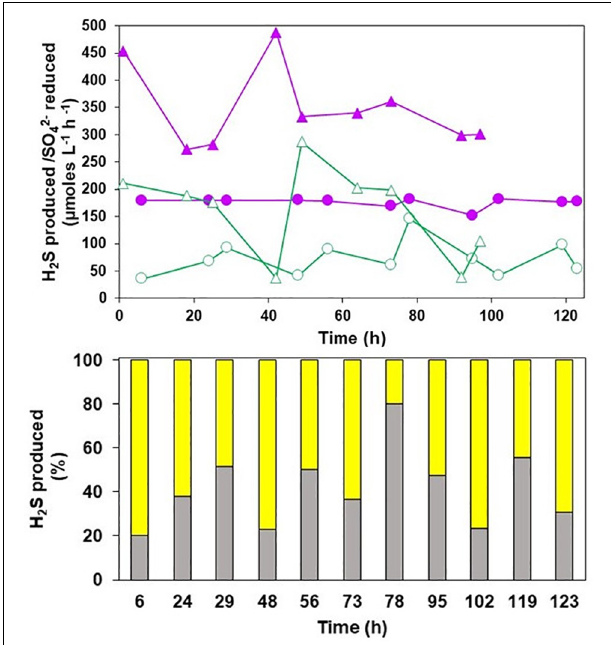
FIGURE 4 | (Top) Rates of hydrogen sulfide production (closed symbols) and sulfate reduction (open symbols) during in-line treatment of synthetic mine water ( (cid:78) , (cid:77) ) and actual MIW ( • , ◦ ) from Minsterley Brook. (Bottom) Relative amounts of hydrogen sulfide produced via the dissimilatory reduction of sulfate ( (cid:4) ) and ZVS ( (cid:4) ) during treatment of actual MIW from Minsterley Brook.